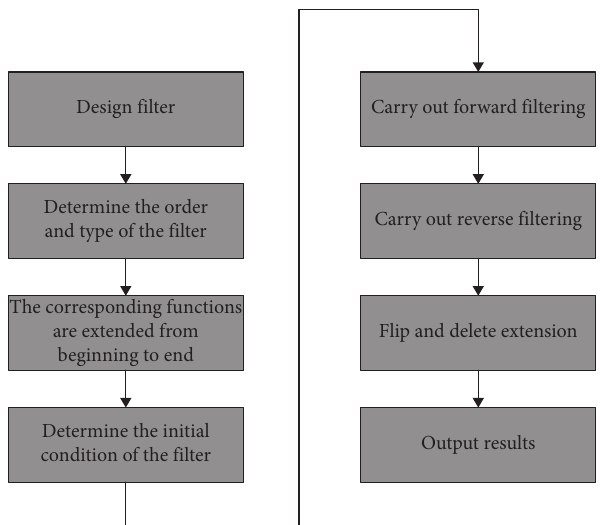
Figure 7: Flow chart of complementary filtering algorithm for wearable intelligent devices.